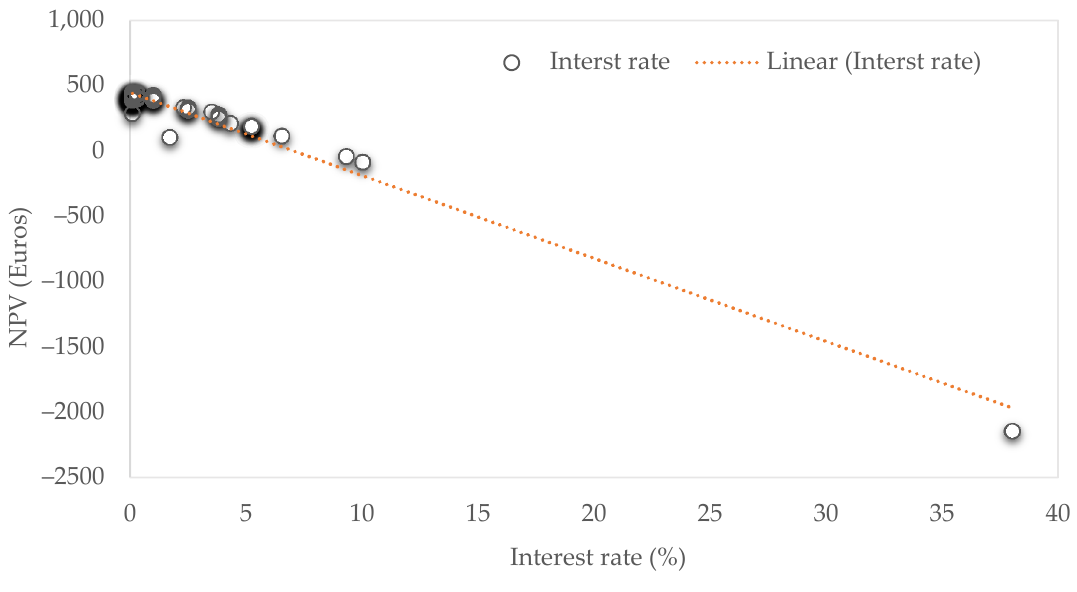
Figure 27 - Correlation of NPV potential variation with interest rate.